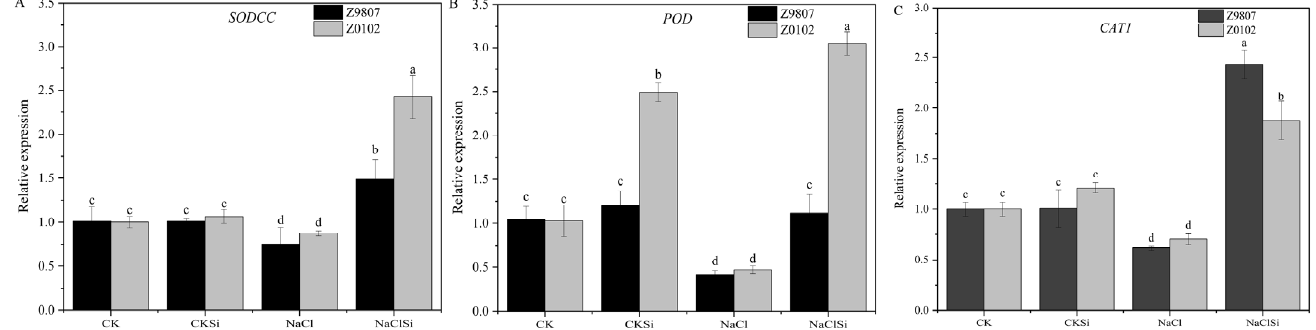
Figure 5. Expression of SODCC ( A ), POD ( B ), and CAT1 ( C ) in cotton functional leaf. Error bars represent the standard error ( n = 3). Different letters mean significantly different among treatments at p ≤ 0.05.